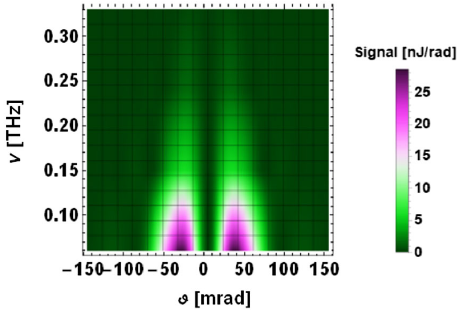
FIG. 5. Simulation of spectral-angular characterization of the CTR light emitted by a 215 MeV, 40 pC, 1.5 ps long electron bunch in the prewave zone at a distance 30